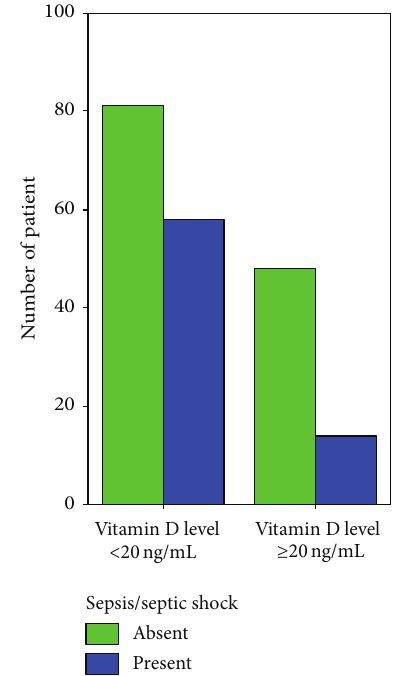
Figure 7: Sepsis/septic shock on admission in Vitamin D insuffi- cient and sufficient patients (𝑃 = 0.026)